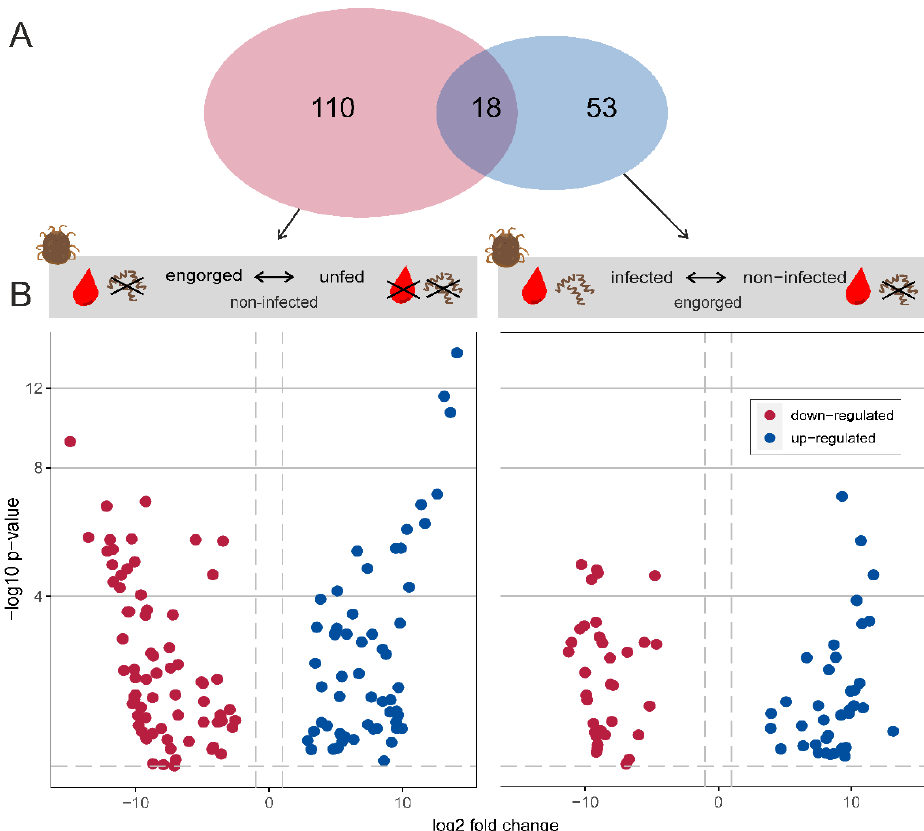
Figure 3. Differential expression analysis. ( A ) Venn diagram showing the total number of differentially expressed transcripts in each experimental group. ( B ) Volcano plot showing differentially expressed transcripts between the states “engorged vs. unfed—non-infected” and “ Borrelia duttonii - infected vs. non-infected—engorged”. Blue and red dots represent up- and down-regulated transcripts, respectively. The dashed lines indicate the used thresholds of 0.05 for adjusted p -value and |1| for log2 foldchange.